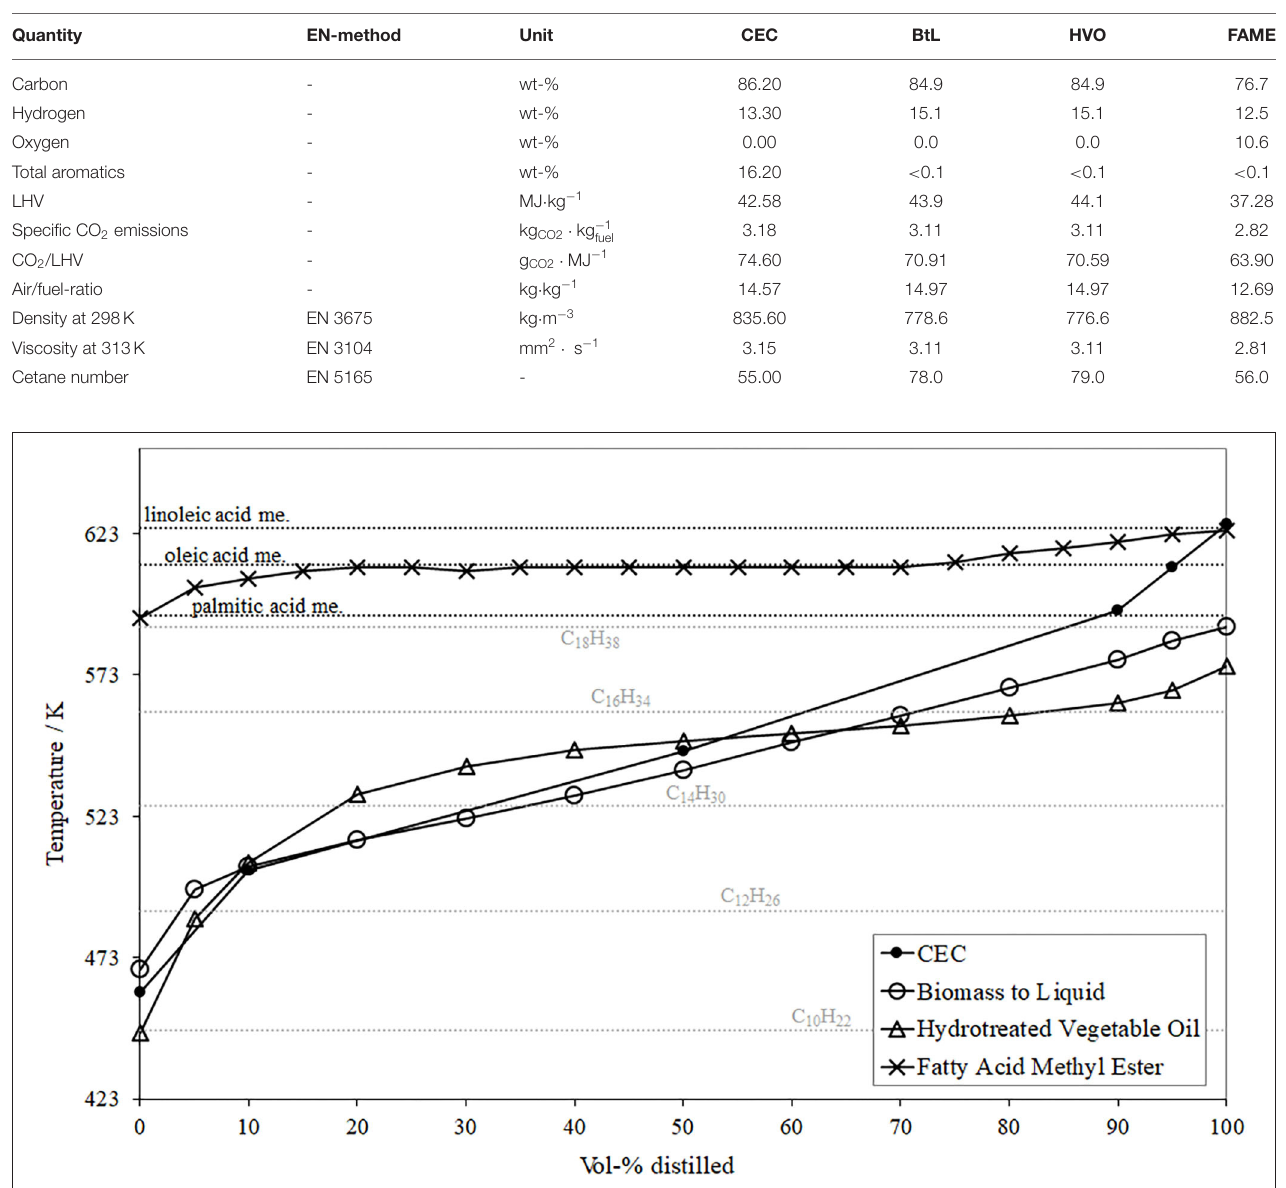
TABLE 2 | Properties of pure test fuels (Moeltner et al., 2017).